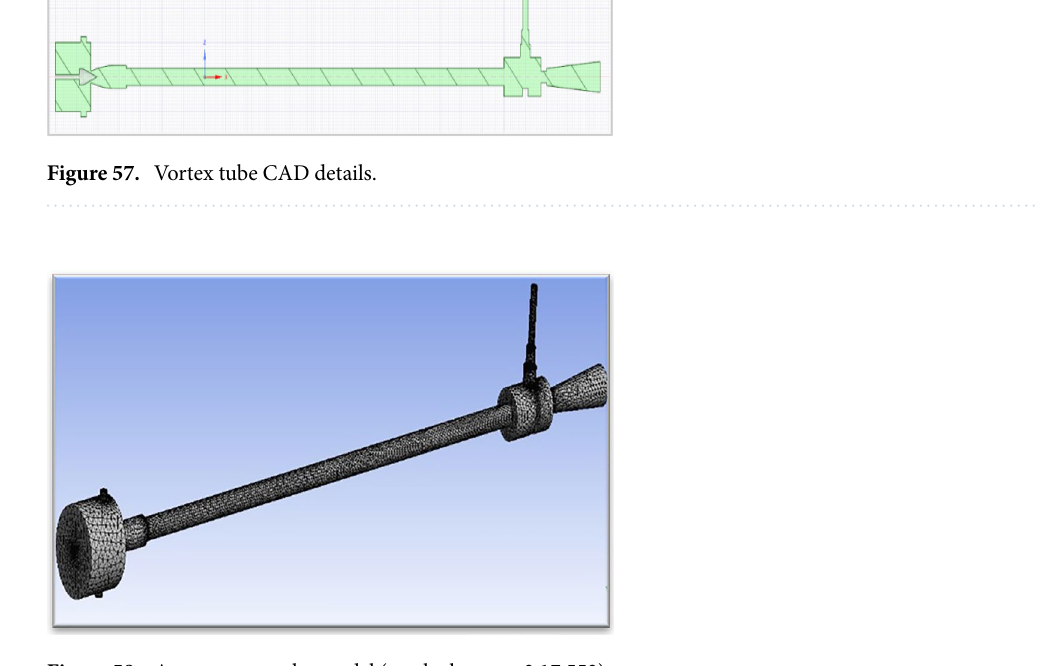
Figure 58. Ansys vortex tube model (mesh elements